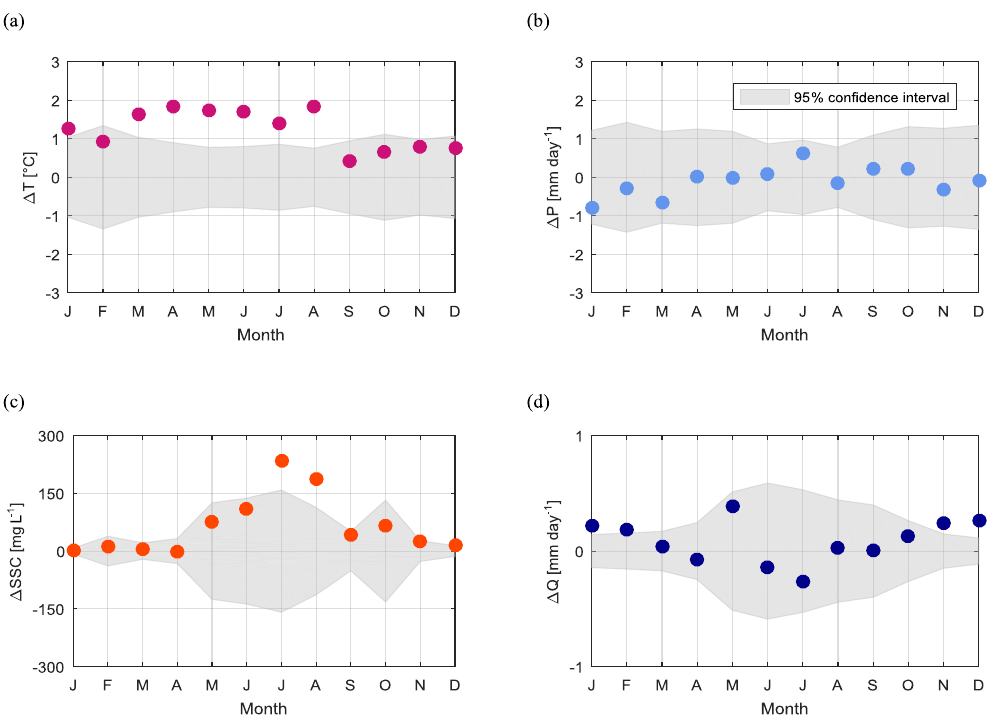
Figure 7. Monthly differences between the period after and before the year-of-change (1987–2015 and 1965–1986) of: (a) basin-averaged air temperature, (b) basin-averaged daily precipitation, (c) mean suspended sediment concentration measured at the outlet of the basin, and (d) daily discharge per unit area measured at the outlet of the basin. Points outside the confidence interval (grey shaded area) represent statistically significant (5% significance level) changes in the monthly